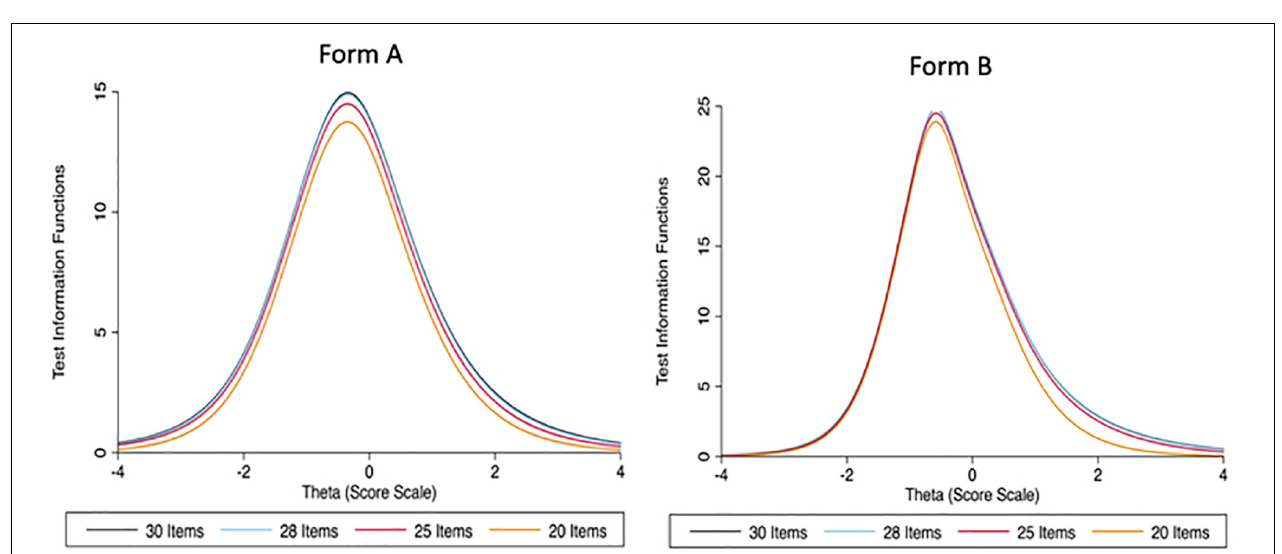
FIGURE 4 | Test Information Functions (TIF) for Form A and Form B of the first version of the ACCE-V for 30 items, 28 items, 25 items, and 20 items,